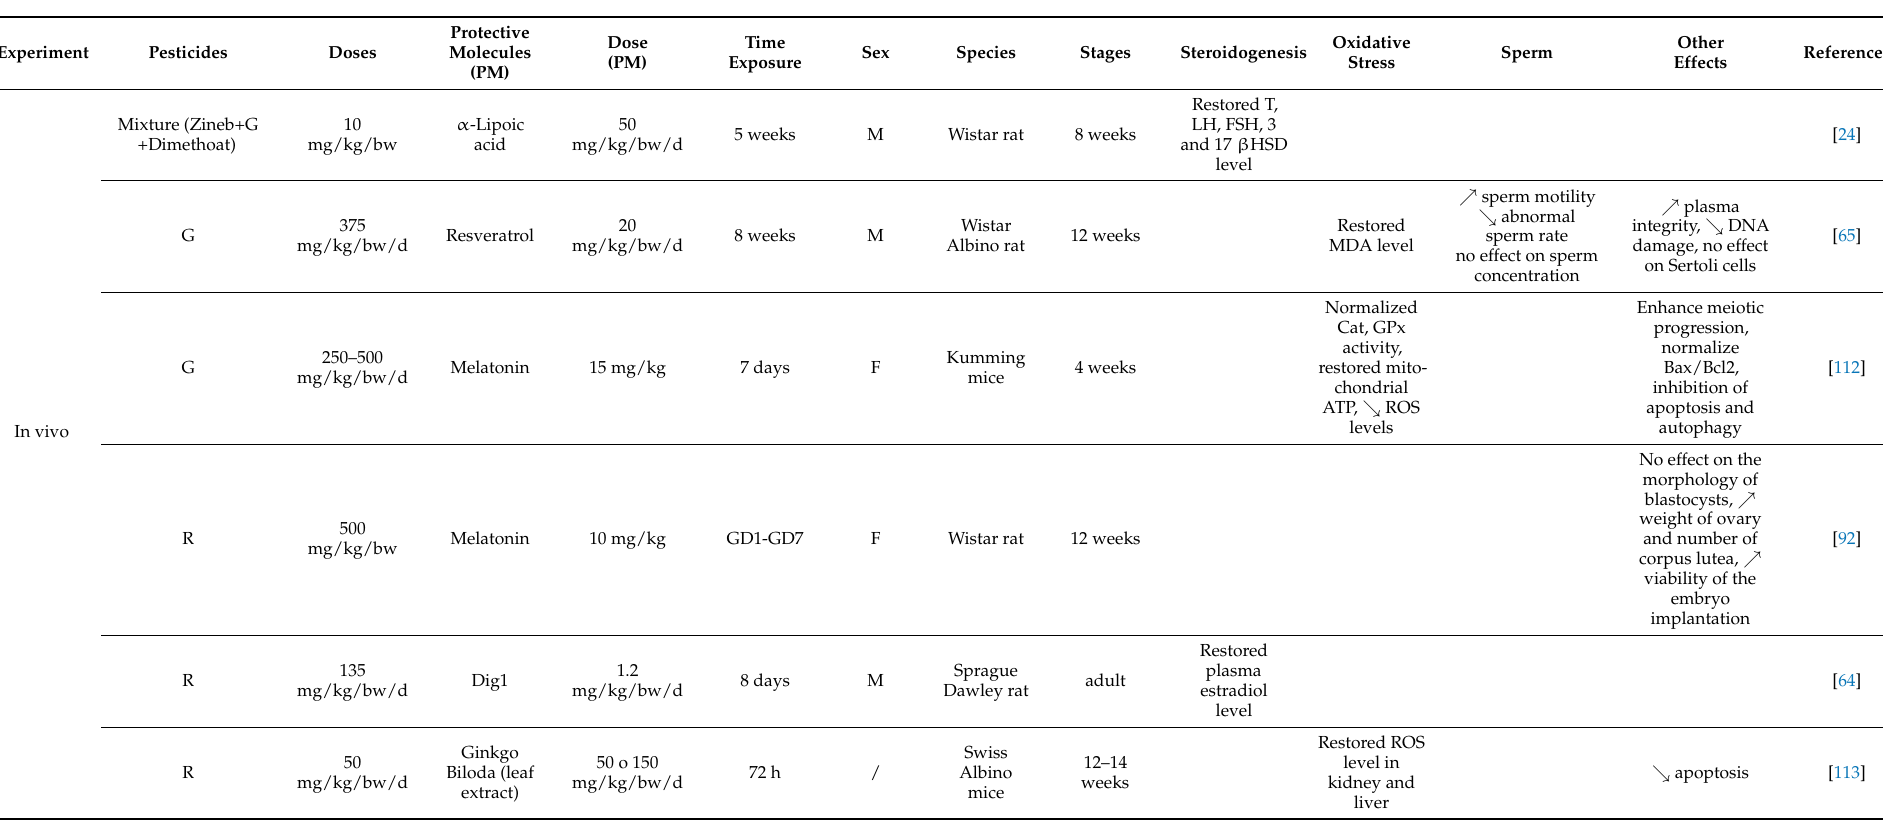
Table 7. Summary of studies on protective molecules against GBH exposure impact on fertility. M: male; F: female; PM: protective molecules; ROS: Reactive Oxygen Species; Cat: Catalase, MDA: Malondialdehyde; SOD: Superoxide dismutase; GST: glutathion S-transferase, GPx: Glutathion Peroxidase. Numbering in brackets indicate